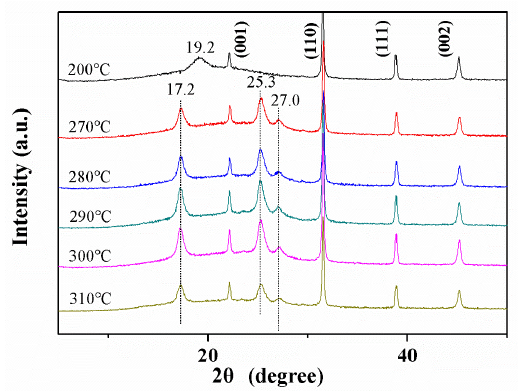
Figure 10. XRD patterns of BT@ZnPc-GO-1/PEN nanocomposite films with 15 wt % BT@ZnPc-GO-1 after isothermal annealing at 200, 270, 280, 290, 300 and 310 °C for 2 h.